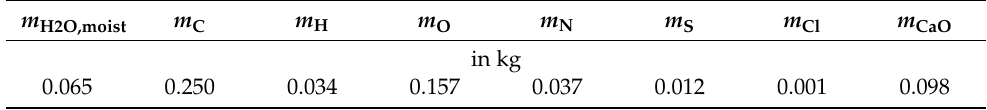
Table 5. Fuel input masses for FactSage equilibrium calculation for gasification of 1 kg as used sewage sludge, ash components other than CaO were neglected.